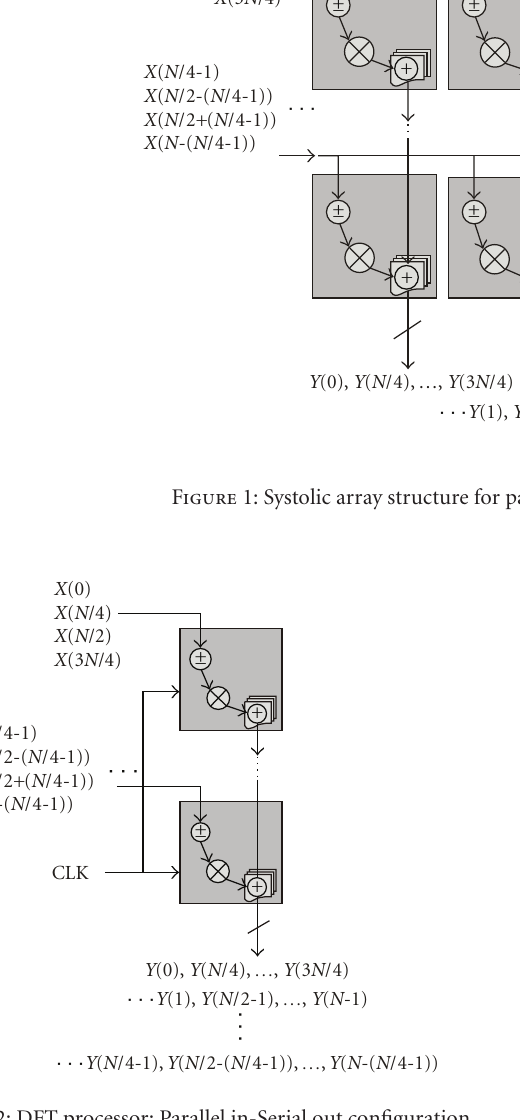
Figure 2: DFT processor: Parallel in-Serial out